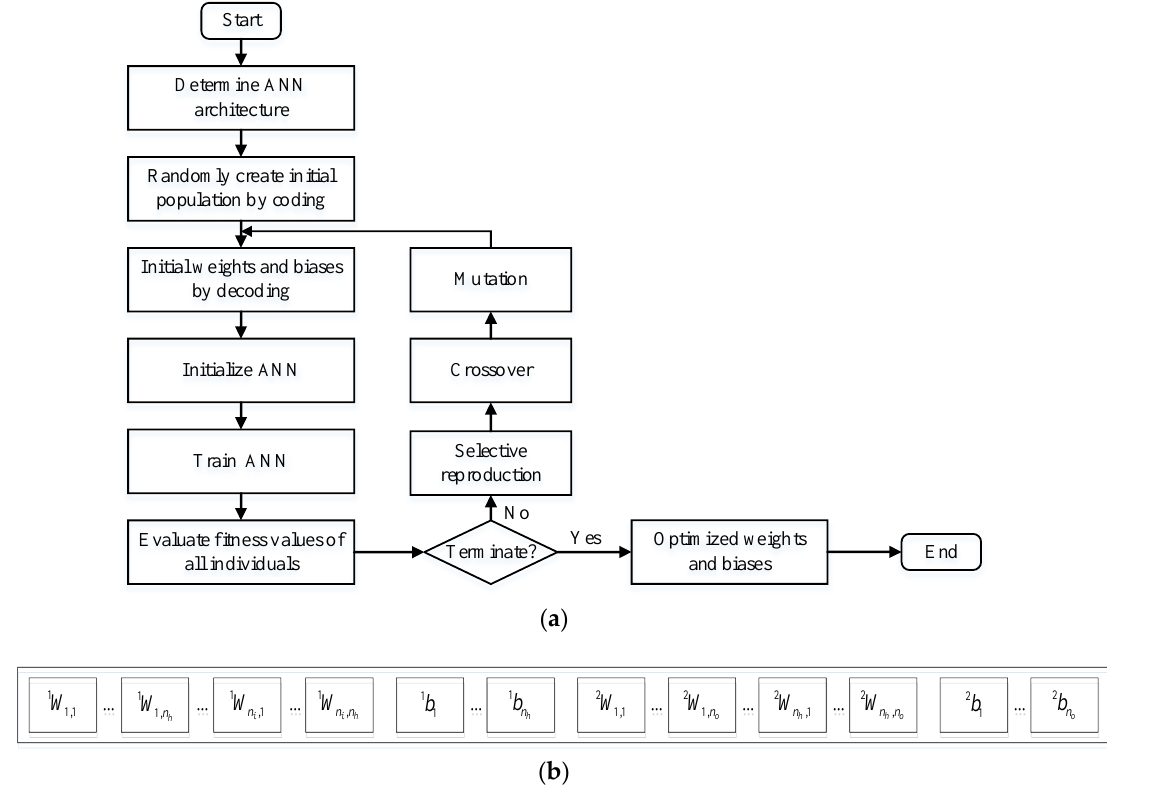
Figure 6. GA optimized ANN algorithm: ( a ) Flowchart; ( b ) An example of storing weights and biases of an ANN model in the genes of a chromosome.